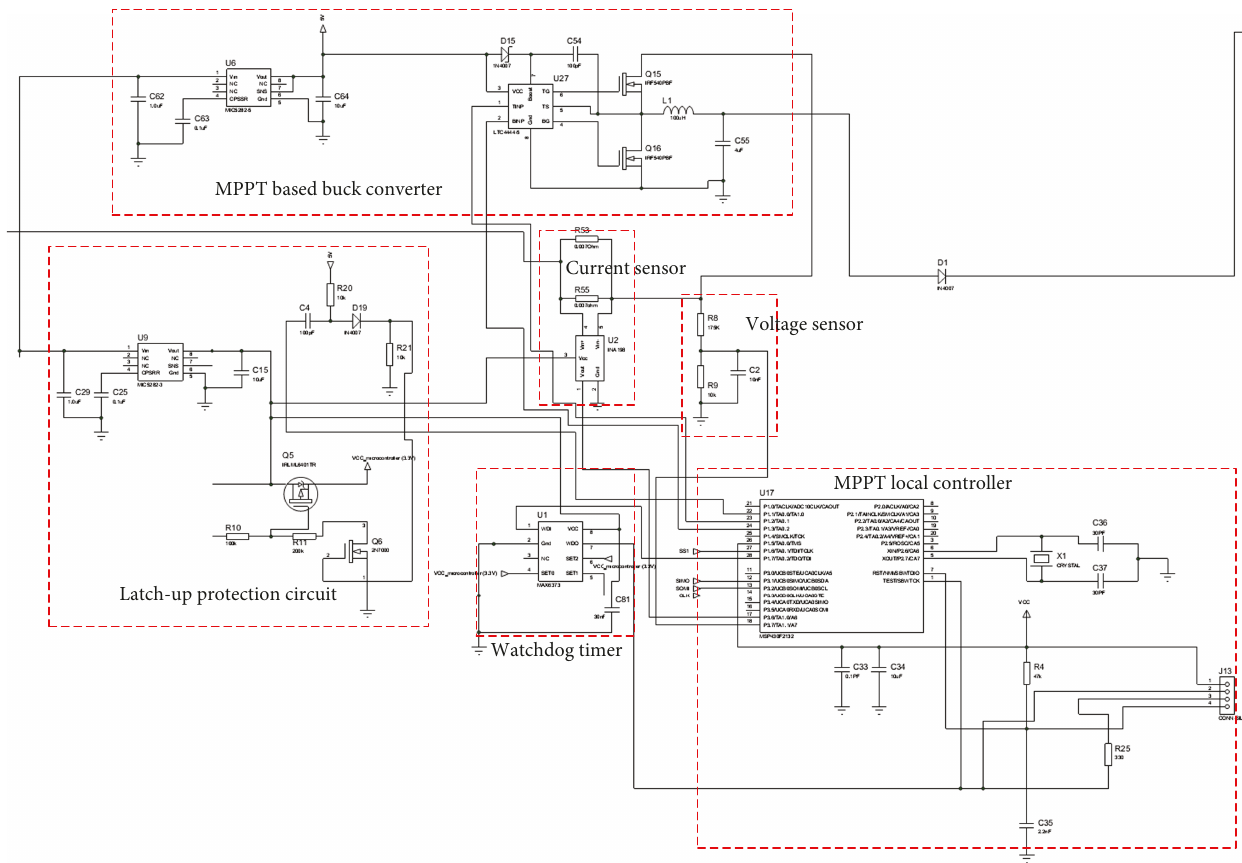
Figure 5: Single MPPT buck converter